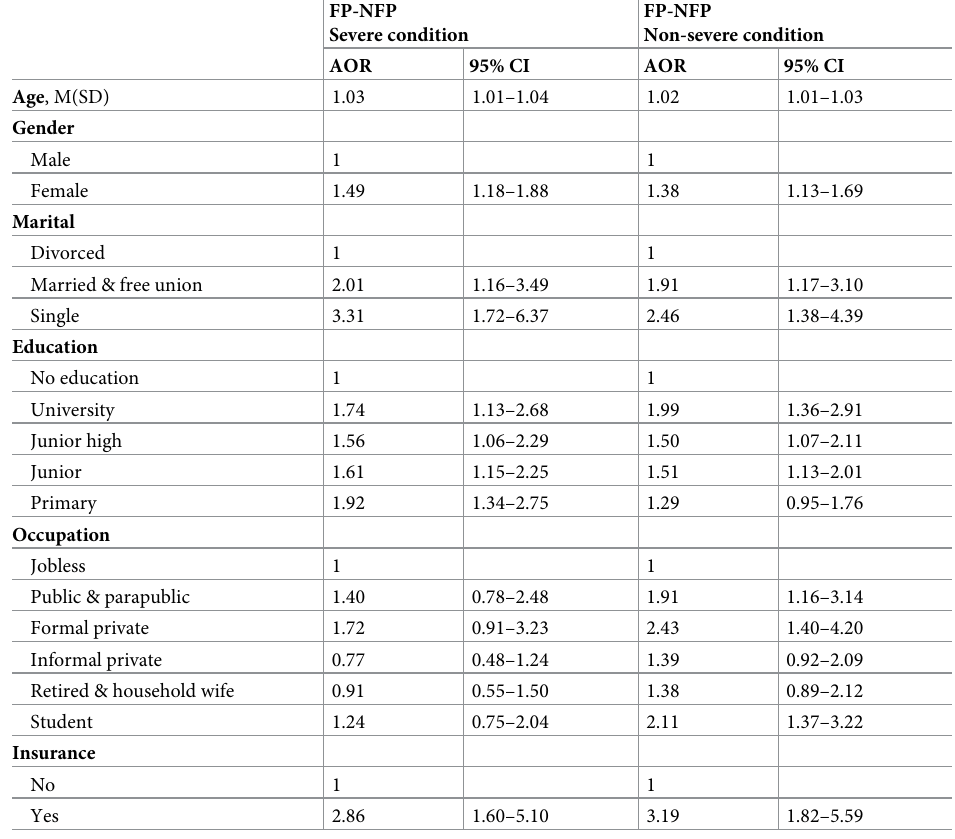
Table 4. Multivariable logistic regression of the choice of FP versus NFP health facilities, by severity of